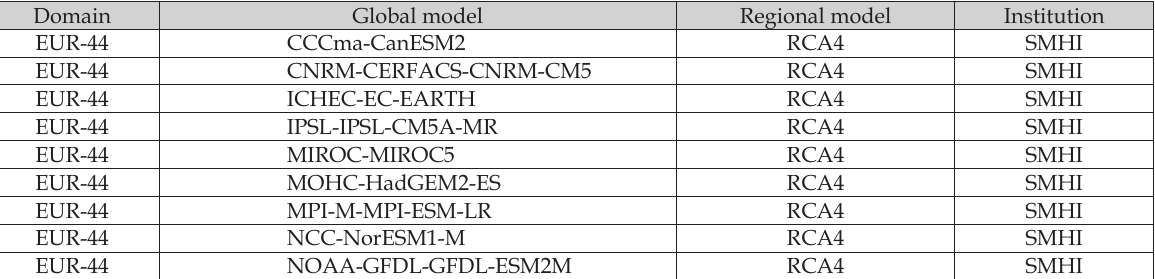
Table 1. List of simulations used in the